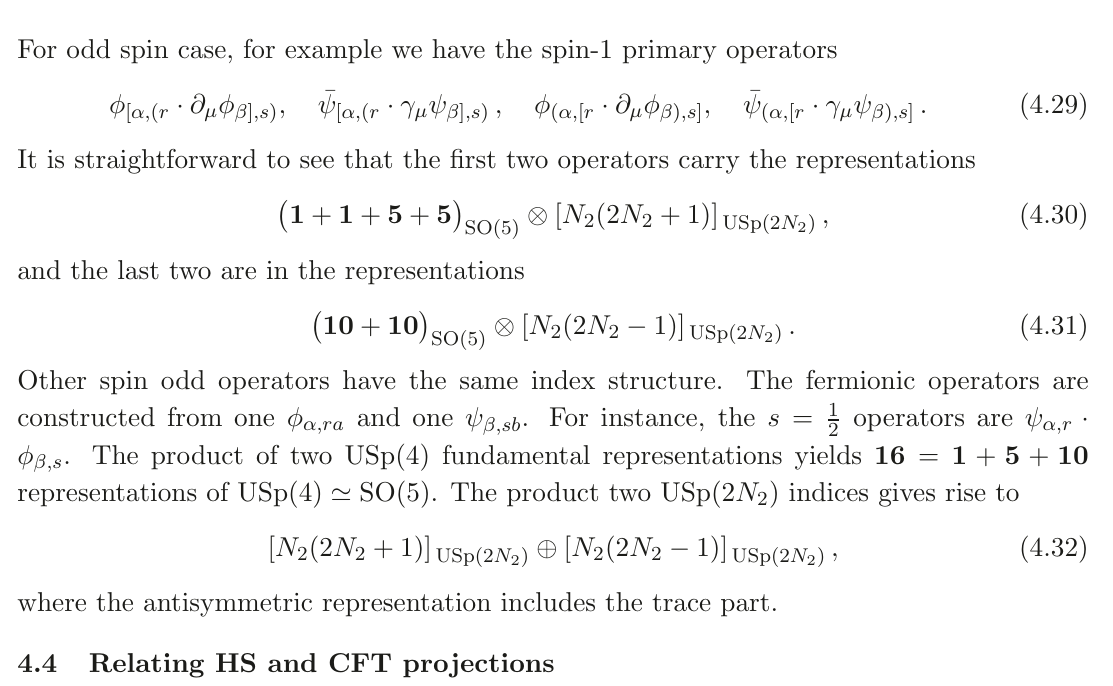
Table 5 . The spectrum of HS primary operators in the Young tableaux denotes the representation of USp(2 N